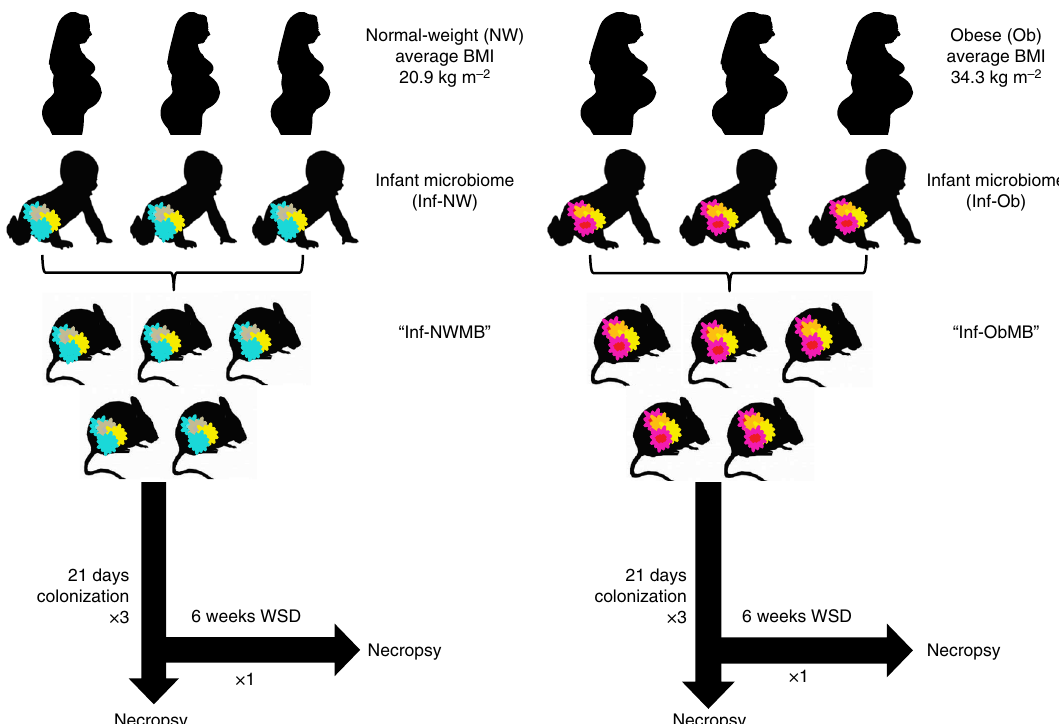
Fig. 1 Diagrammatic representation of experimental design. Stool from three different 2-week-old infants born to normal-weight (NW) or obese (Ob) mothers was pooled in an anaerobic chamber. Pooled samples from each group, Inf-NWMB or Inf-ObMB, were gavaged into 3 – 5 GF mice per group and the inoculated mice were colonized for 21 days on a chow diet. This experiment was repeated three times using unique pooled samples of infant stools for each round of colonization. To study the effect of WSD, a fourth experiment was performed with 4 GF mice per group and following the 21-day colonization, mice were switched to a WSD for 6